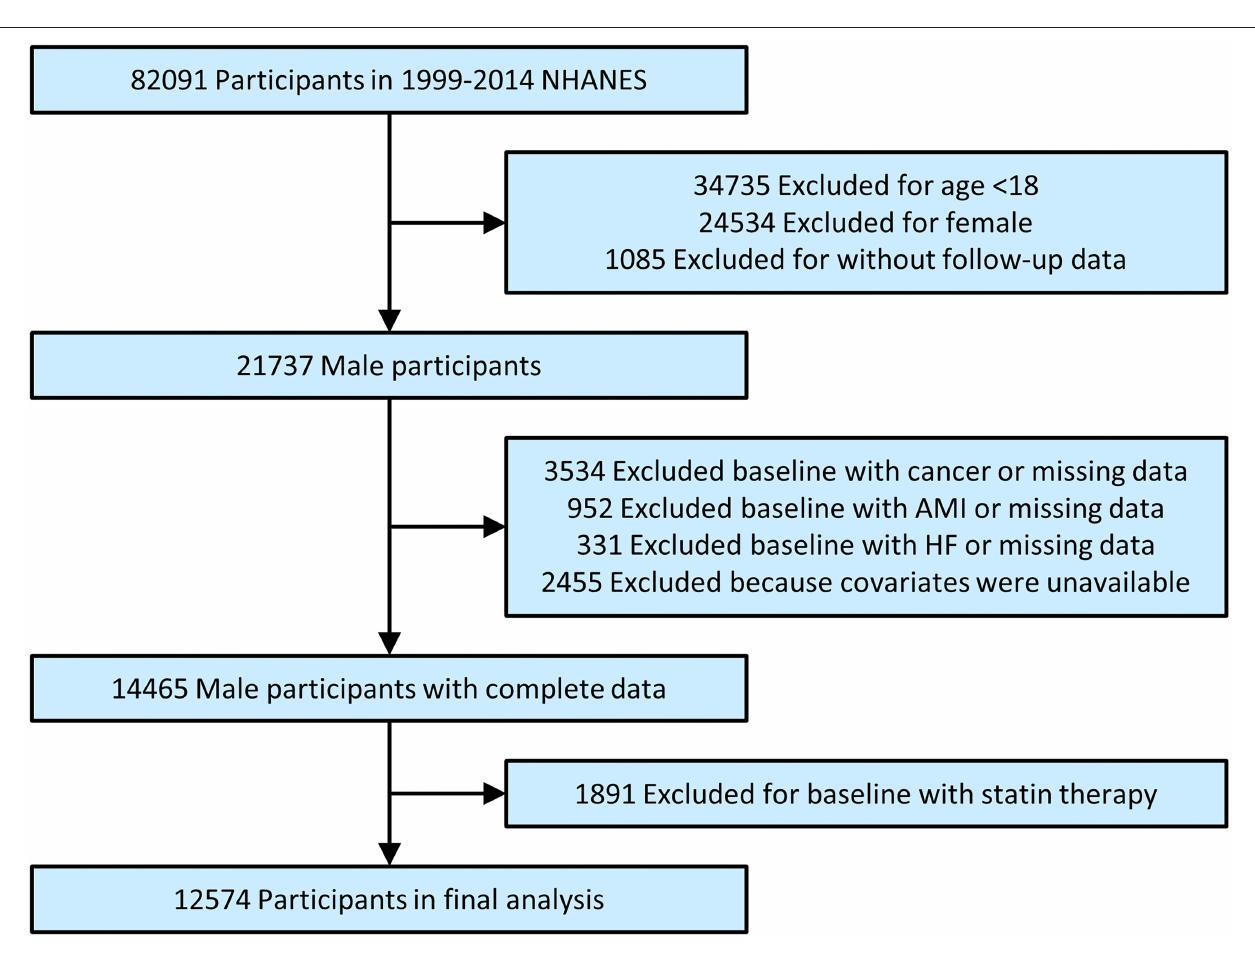
FIGURE 1 | Study flowchart. NHANES, National health and nutrition examination survey; AMI, acute myocardial infarction; HF, heart failure.